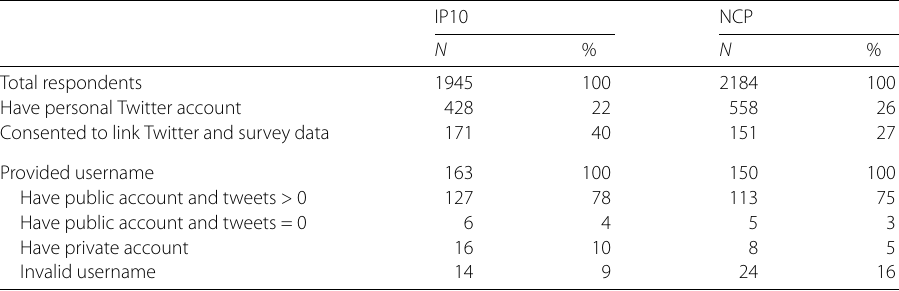
Table 1 Outcome of Twitter Data Collection in IP10 and NCP. Conditional